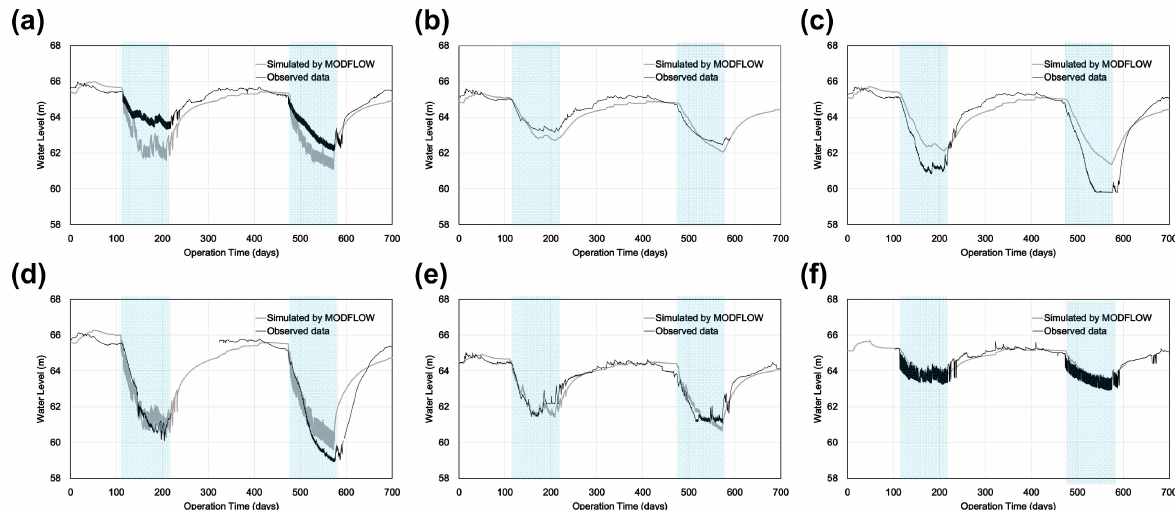
Figure 5. Comparisons between observation and simulated results by MODFLOW for a two-year seasonal groundwater exploitation owing to water curtain cultivation (WCC) for monitoring wells of ( a ) CWW-04, ( b ) CWW-05, ( c ) CWW-07, ( d ) CWW-08, ( e ) CWW-11, and ( f ) OB-11 (blue boxes represent WCC